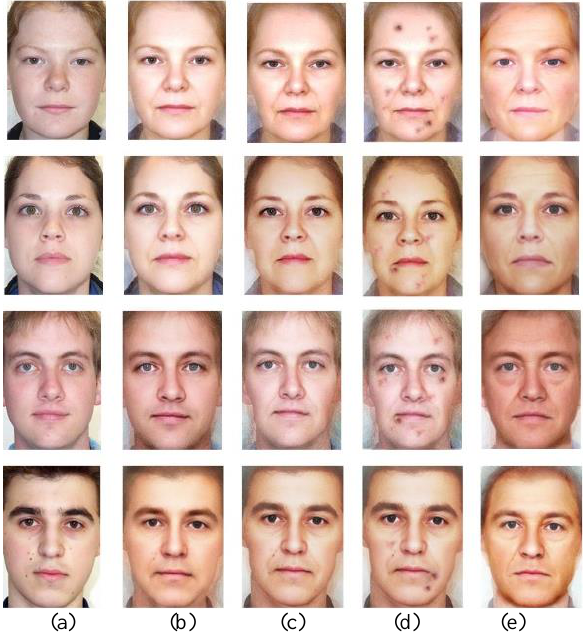
Figure 2 . Results of applying predictive models to